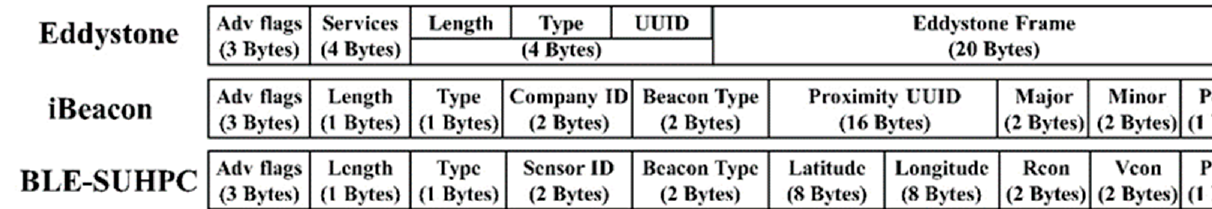
Figure 3. Developed wireless sensing system.